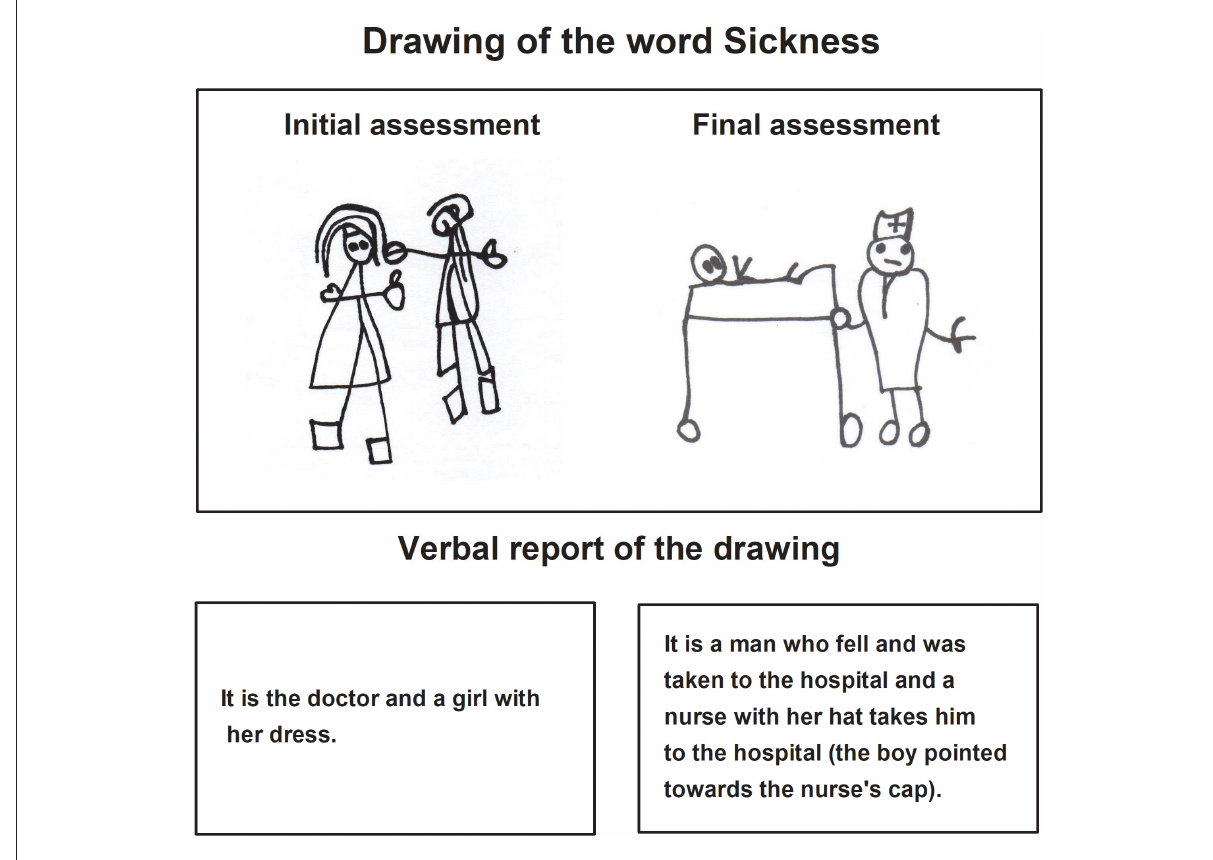
FIGURE1 Child A drawing in the pictogram task during the initial and final